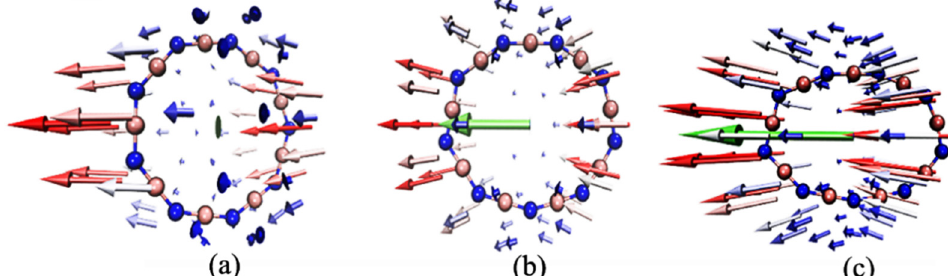
Figure 6. Visualization of the first hyperpolarization at different EEF strengths. ( a ) EEF = 0 a.u., ( b ) EEF = 0.015 a.u., ( c ) EEF = 0.025 a.u. The direction of the green arrow reflects the total trend (vector sum) of all arrows of the system, and its length reflects the intensity of the first hyperpolarization rate.